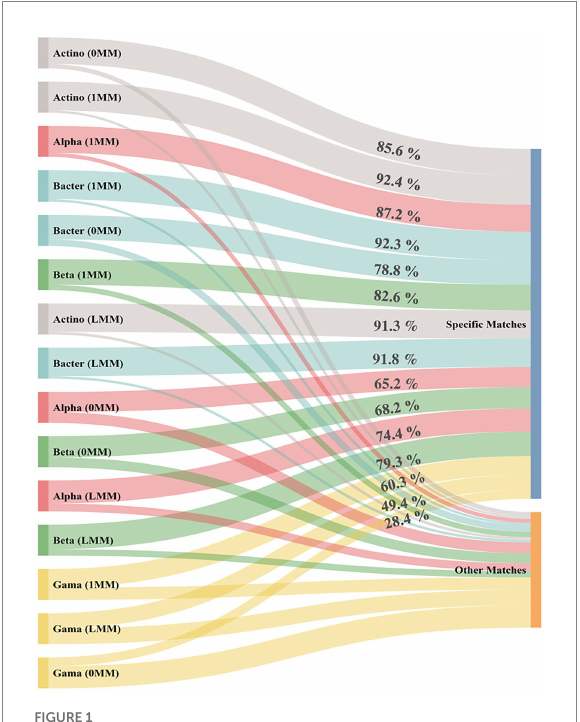
FIGURE 1 In silico prediction of the target coverage percentage (specific match) and non-coverage (other matches) for each phylum- specific primer pair using TestPrime tool. 0MM represents the 0 mismatch condition, while 1MM represents the 1 mismatch condition. LMM represents the logic mismatch condition where the mismatch does not occur in the last three bases in the 3 ′ end. Actino; Actinobacteria, Alpha; Alphaproteobacteria, Beta; Betaproteobacteria, Gama; Gammaproteobacteria, Bacter;